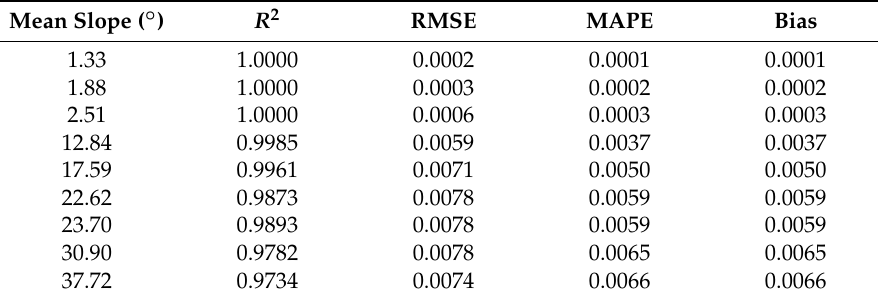
Table 3. Accuracy statistics of the modeled BSA over different simulated DEMs.